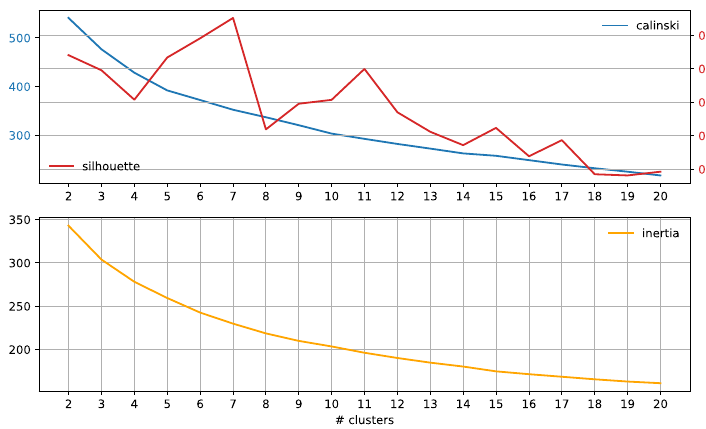
Figure A11. Subreddit ankylosingspondylitis.